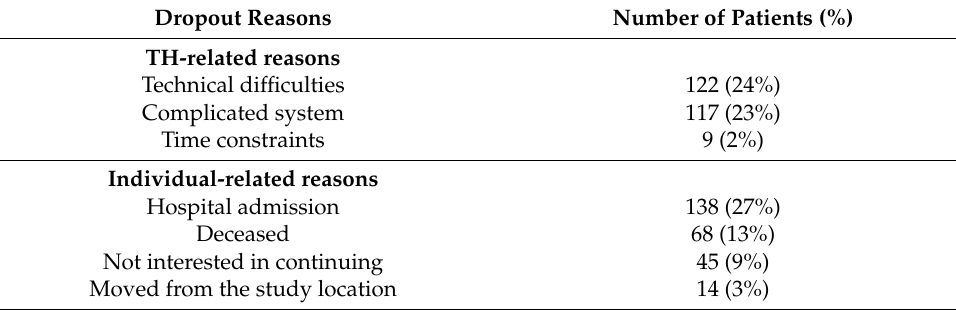
Table 3. Most common reasons for dropout from TH interventions ( n = 513) a